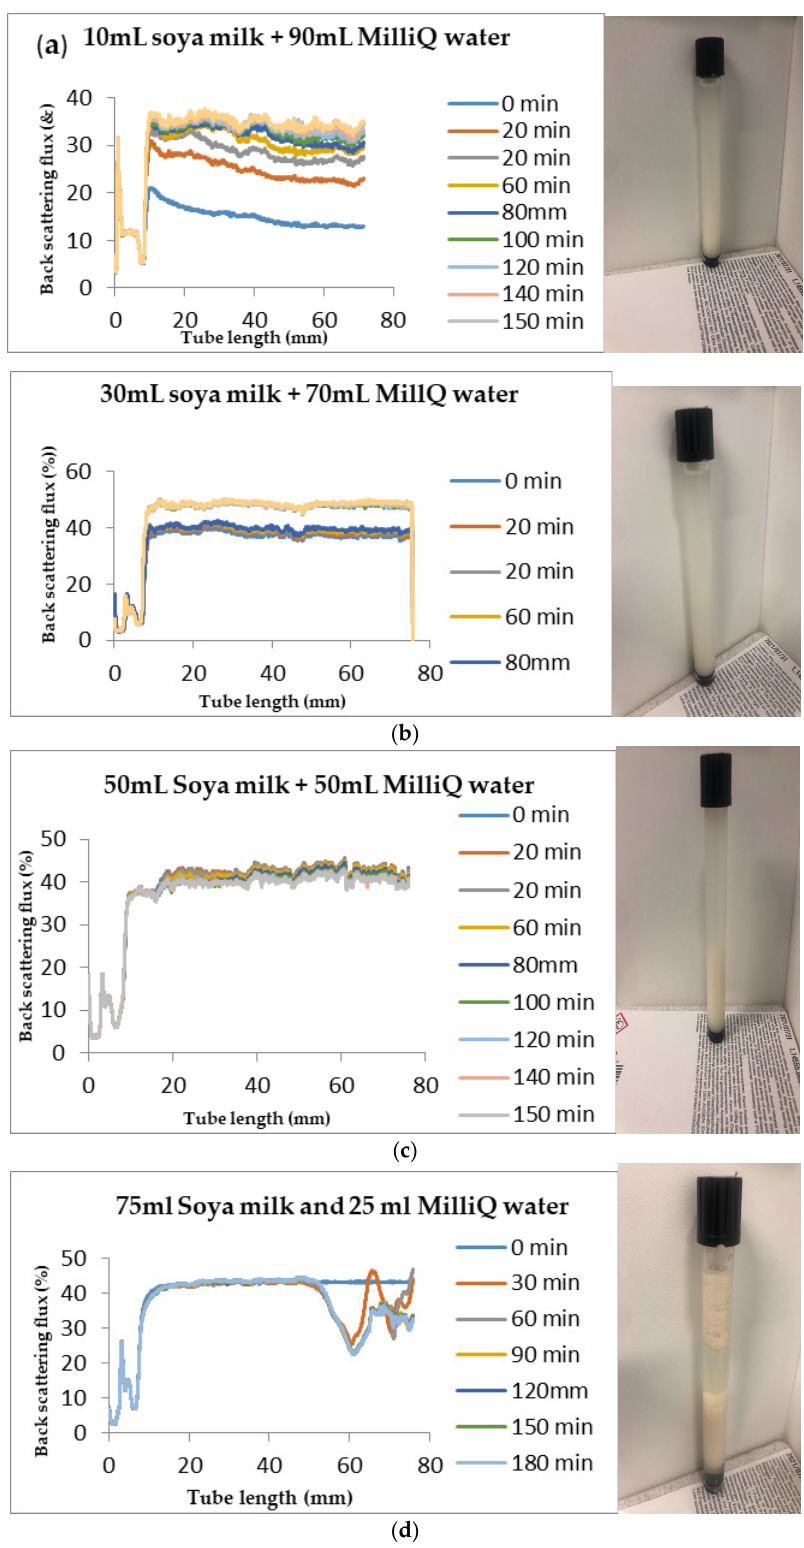
Figure 6. Changes in stability of ACM-stabilized 75 mL ( w / w ) soya milk emulsions ( a ) 1 g w / w ; ( b ) 3 g w / w ; ( c ) 5 g w / w African catfish mucus.